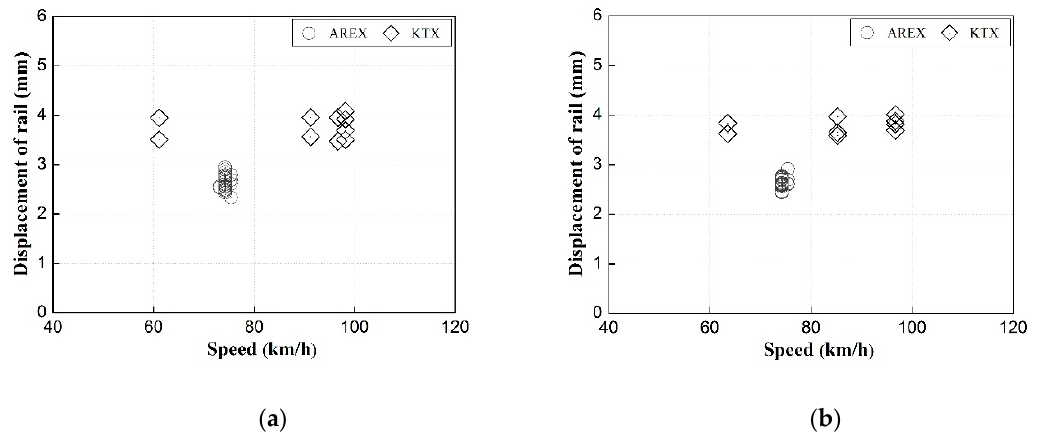
Figure 8. Measured displacement of the rail by train type. ( a ) Before rail pad replacement and ( b ) after rail pad replacement.